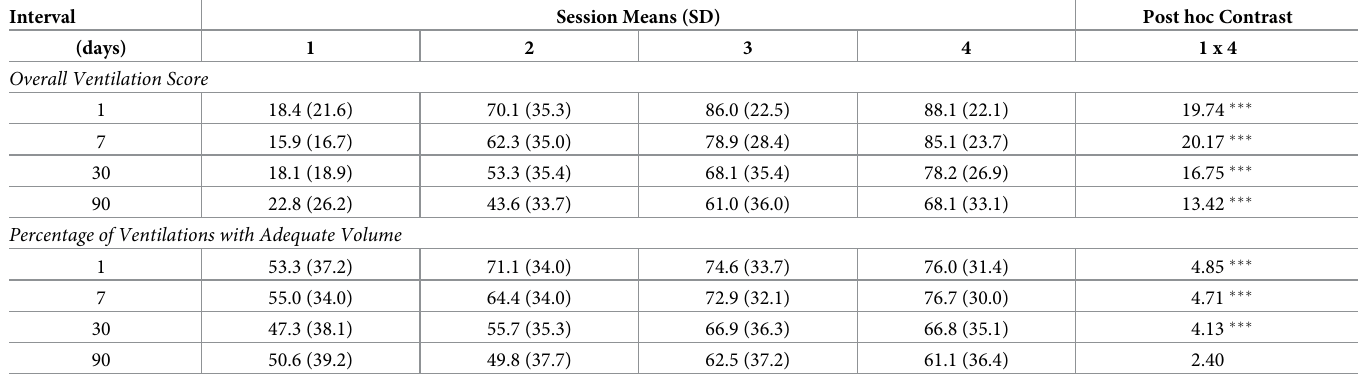
Table 2. Pretest means (SD) for ventilation measures across sessions and intervals. Contrasts provide post hoc comparisons of session 1 and 4 for each interval, with t- values and significance levels at � p < .05, �� p < .01, and ��� p < .001. Interval Session Means (SD) Post hoc Contrast (days) 1 x